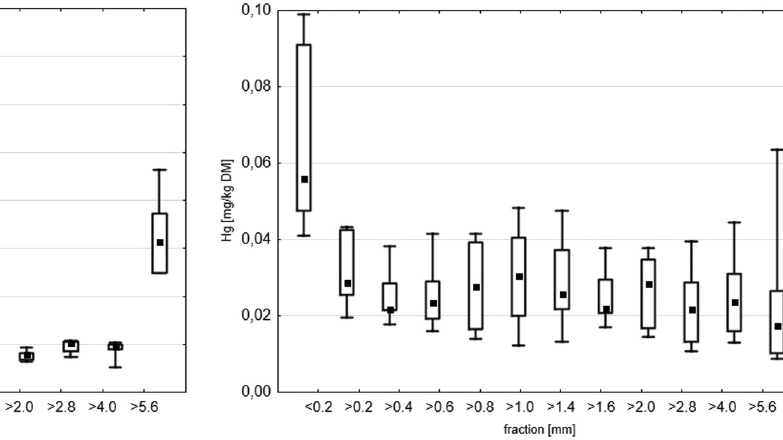
Figure 5: Box and whisker plots of Hg content ( mg kg − 1 ) in LFW fractions. The edges of the boxes show the SD, the whiskers show min – max, respectively. The mean is marked with a square point.